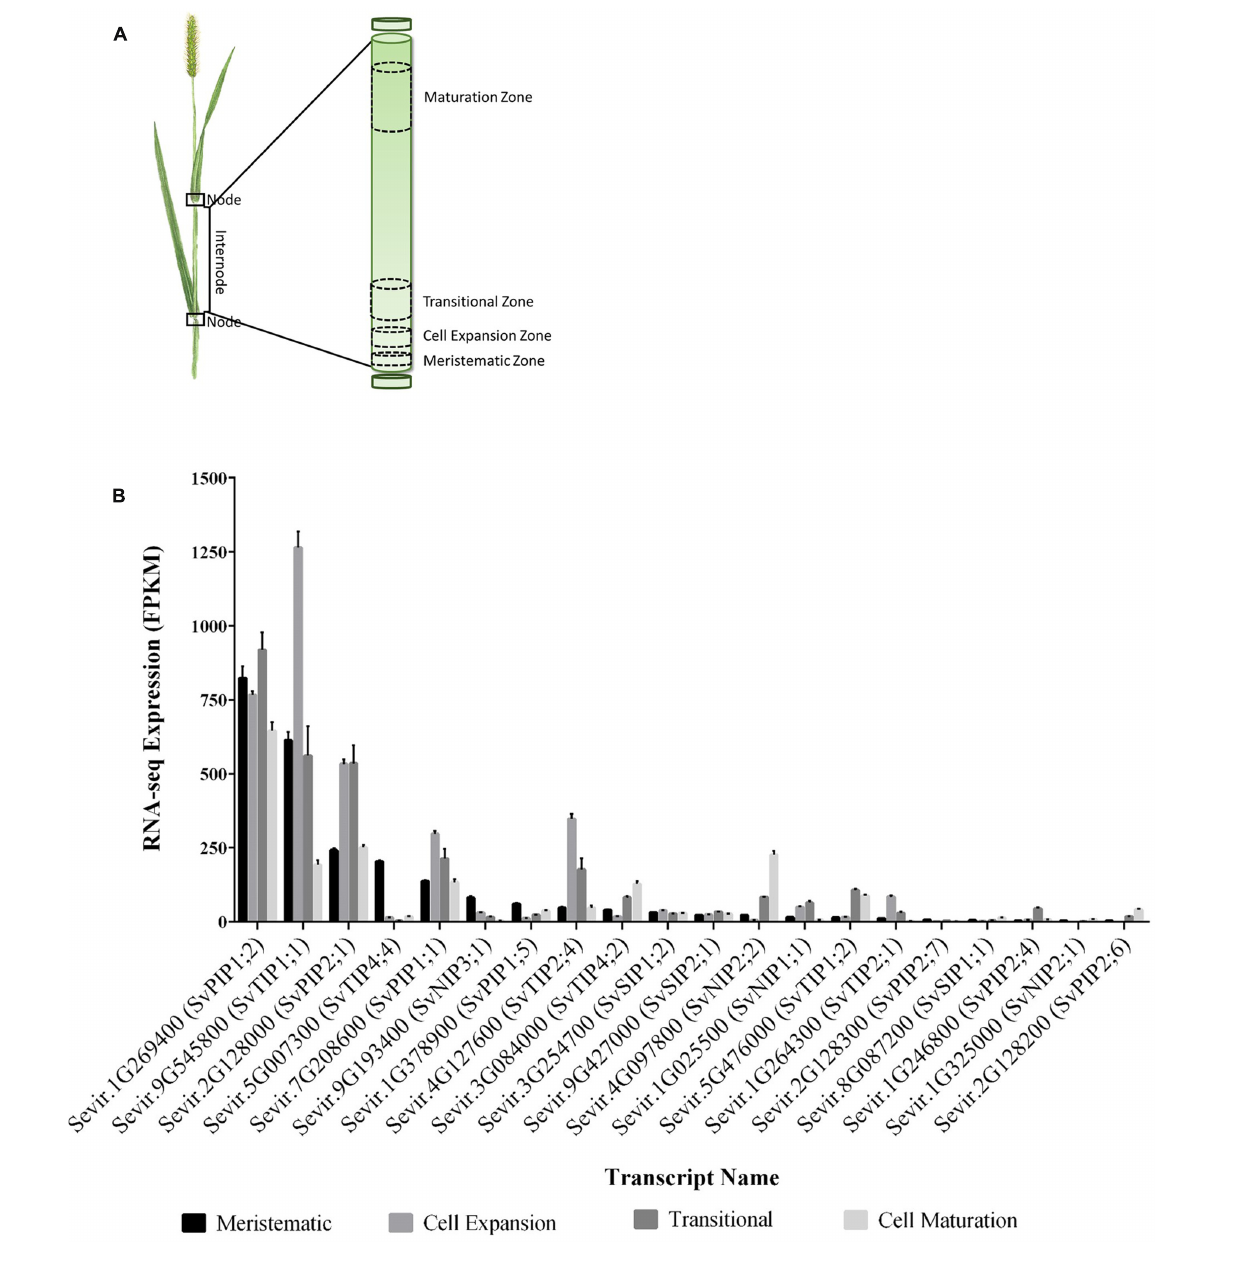
FIGURE 2 | Expression of putative aquaporins across the developmental zones of an elongating S. viridis internode. (A) Schematic of the developmental regions in an elongating internode of S. viridis as reported by Martin et al. (2016): meristematic zone, residing at the base of the internode, where cell division occurs; the cell expansion zone where cells undergo turgor driven expansion; transitional zone where cells begin to differentiate and synthesize secondary cell walls; and the maturation zone whereby expansion, differentiation and secondary cell wall synthesis cease and sugar is accumulated. (B) The expression profiles of putative S. viridis aquaporins, as identified by phylogeny to Z. mays aquaporins, were mined in the S. viridis elongating internode transcriptome (Martin et al., 2016). RNA-seq data is presented as mean FPKM ± SEM for four biological replicates from each developmental